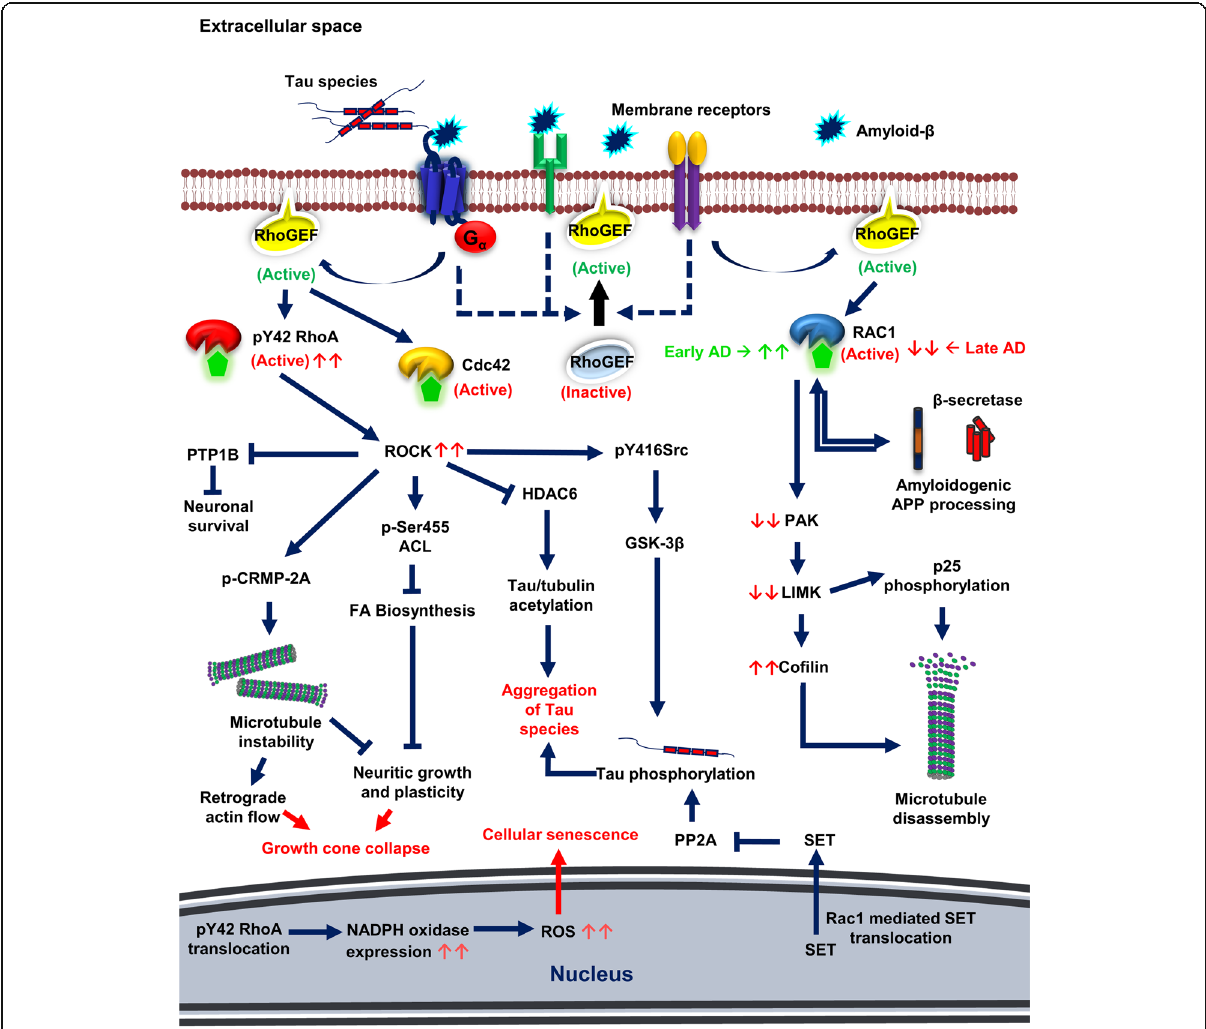
Fig. 4 Pathological signaling of Rho GTPases in Alzheimer ’ s disease. In Alzheimer ’ s disease, the extracellular space is filled with senile plaques of amyloid- β and aggregated Tau species. These disordered proteins interact with several surface receptors, which on activation lead to pathological signaling of Rho-GTPases. Rho-GTPases are highly activated (phosphorylated on Y42) on amyloid- β exposure. Hyperactivation of Rho-GTPases leads to increased activation of ROCK kinases. ROCK kinase phosphorylates Src at Tyrosine 416 and activates to activate GSK-3 β , an enzyme involved in Tau hyperphosphorylation. ROCK also inhibits HDAC6 activity which ultimately promotes Tau and tubulin acetylation. All these post- translational modifications of Tau lead to aggregation of Tau species. ROCK phosphorylates and inactivates CRMP-2A and ATP citrate lyase (p-Ser 455) (ACL). CRMP-2A are microtubule-associated proteins, and its inactivation led to microtubule instability and retrograde flow of actin filaments. Fatty acid biosynthesis is inhibited by ATP-citrate lyase phosphorylation which ultimately inhibits neurite growth, plasticity and leads to growth cone collapse in neuronal cells. Activated ROCK kinases also inhibit protein tyrosine phosphatase 1B and neuronal survival. Phosphorylated RhoA translocates to the nucleus and promotes the expression of NADPH oxidase, increases ROS levels and cellular senescence. Rac1 GTPase expression level varies at different stages and promotes amyloidogenic APP processing during the later stages of Alzheimer ’ s disease leading to more amyloid- β secretion and vice versa. At later stages, Rac1 expression level is reduced, and subsequent effectors PAK and LIMK activities are also downregulated. This condition leads to the imbalance in cofilin (active) and its phosphorylated form (inactive). Excessive cofilin activity causes actin depolymerization and microtubule instability. Under AD conditions, Rac1 also promotes translocation of SET proteins from the nucleus to the cytoplasm that acts as phosphatase inhibitors and ultimately promotes phosphorylation and aggregation of Tau